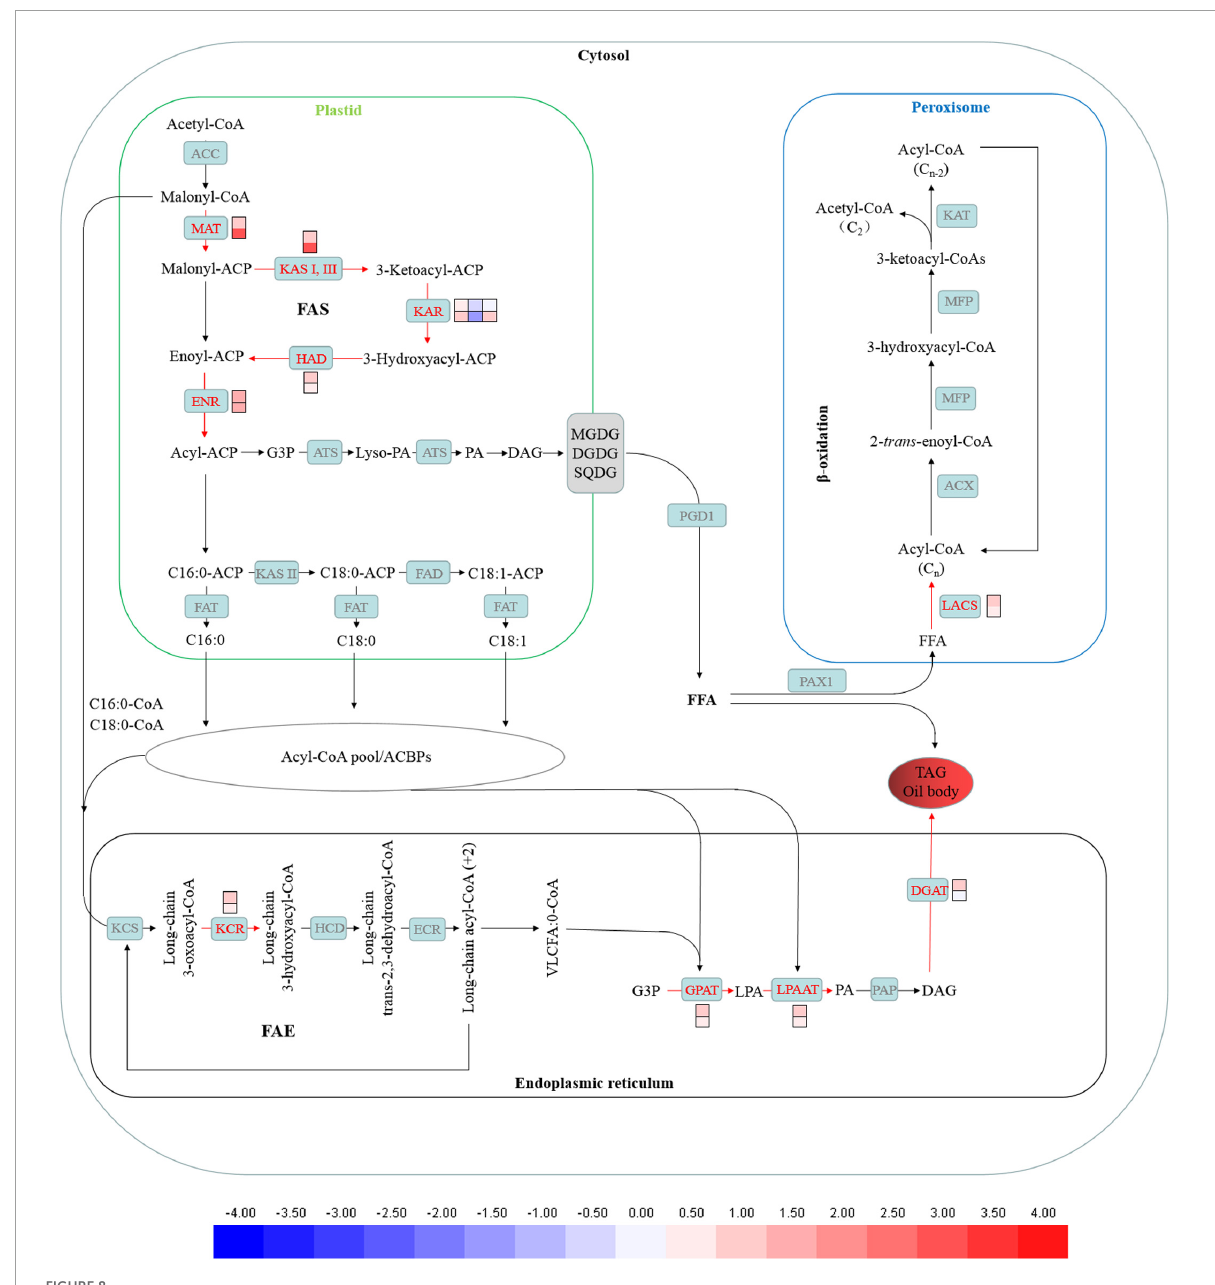
FIGURE8 Changes in fatty acid biosynthesis under CHES treatment in P. tricornutum . The expression of genes participating in lipid metabolism such as de novo fatty acid biosynthesis, TAGs assembly in ER and β -oxidation in peroxisome were determined by RNA-Seq in 2 and 3 days after culture. The upper and lower panels were determined in 2 and 3 days after culture,